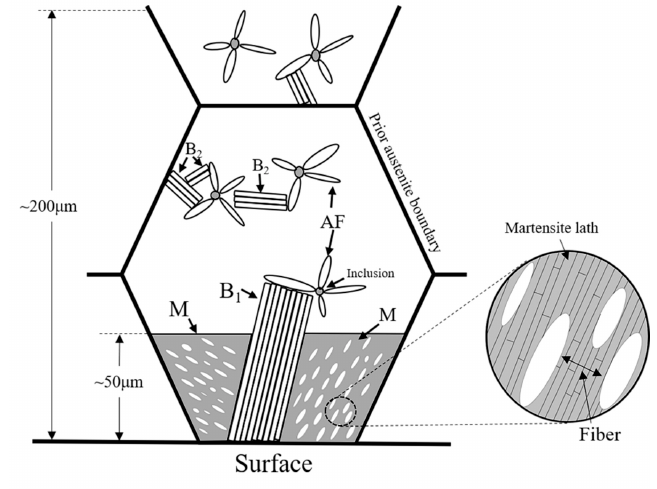
Figure 5. Schematic illustration of mixed microstructure in the surface layer.